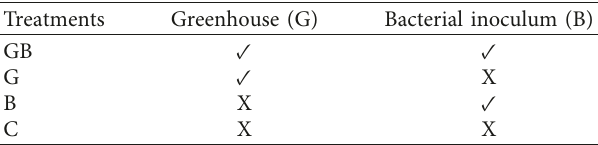
Table 1: Field trial treatments with their respective conditions. Greenhouse (G) indicates seedlings were maintained previously in green house conditions. Bacterial inoculum (B) indicates the mixture of the 5 L. sphaericus strains was added to seedlings.